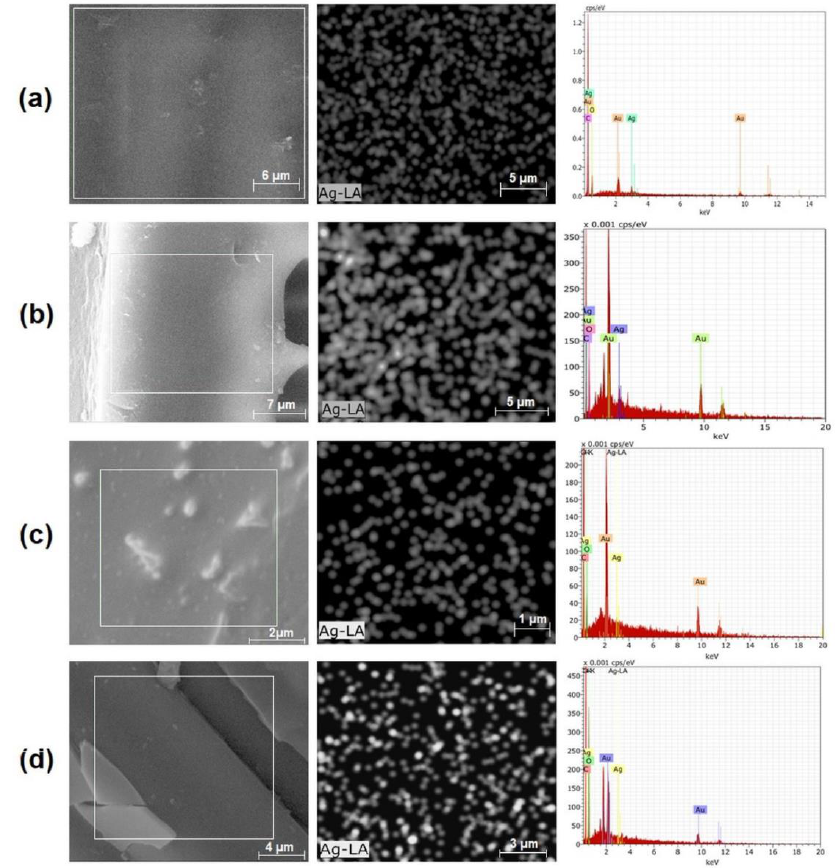
Figure 9. SEM images, EDS mapping of silver, and EDS spectrum from PET fabric modified with hydrogel and AgNPs: ( a ) surface of UV PET 95:5:0.5 , ( b ) cross-section of UV PET 100:0:0.5 , ( c ) surface of γ60 PET 90:10:30 , and ( d ) cross-section of γ60 PET 100:0:50 .